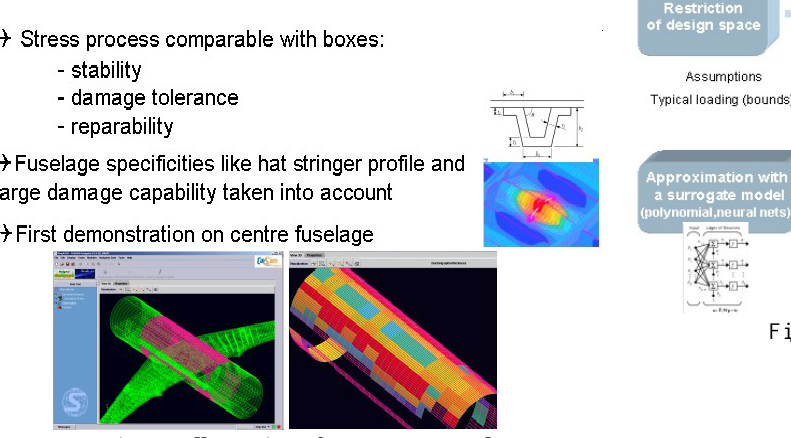
Fig. 14. Illustration of COMFUSE tool